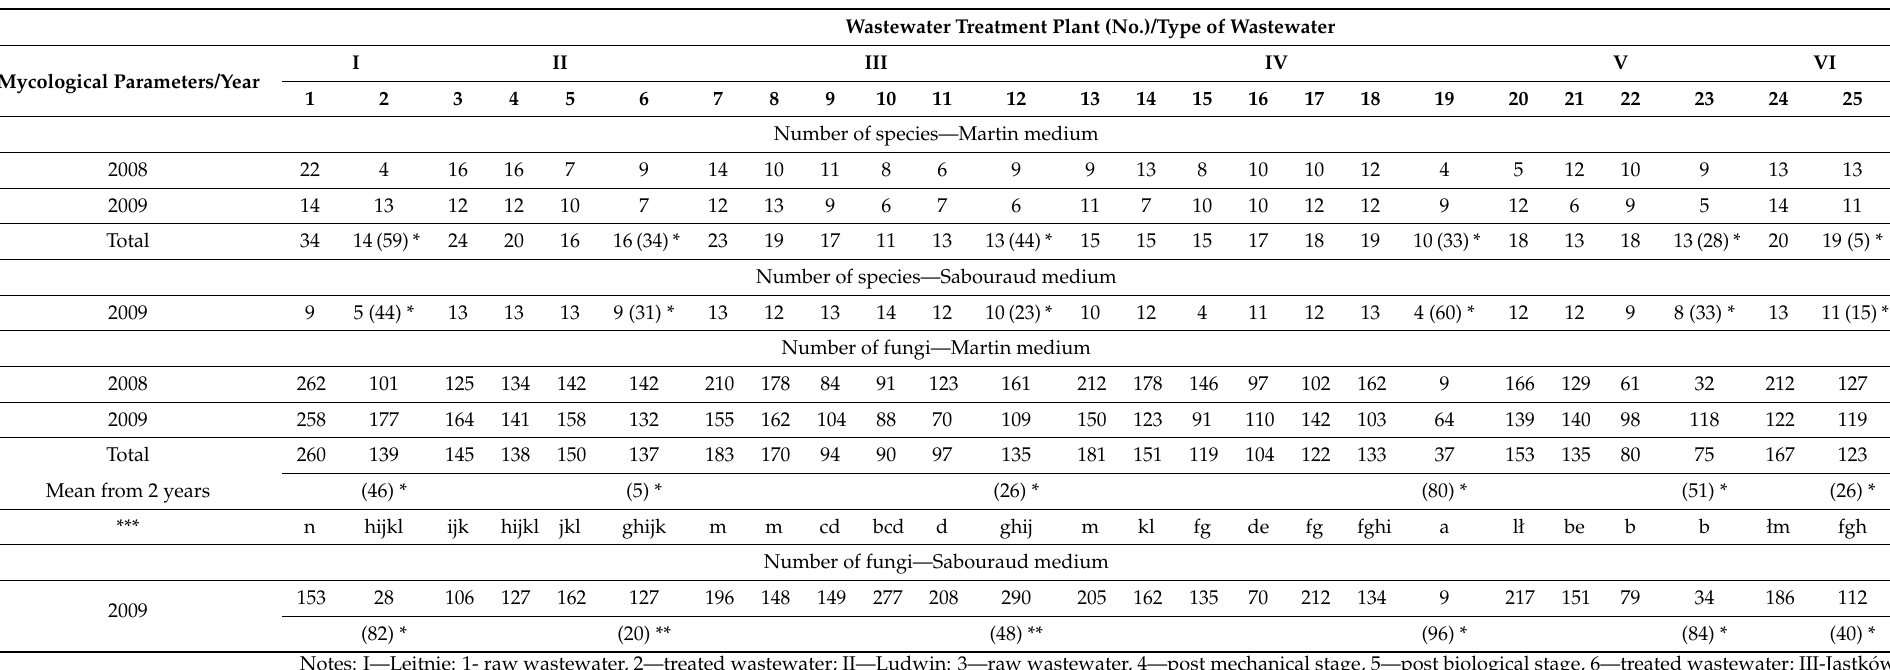
Table 7. Changes in the number of species and the total frequency of filamentous fungi at each wastewater treatment stage (cfu · 10 3 · cm − 3 ). Wastewater Treatment Plant (No.)/Type of